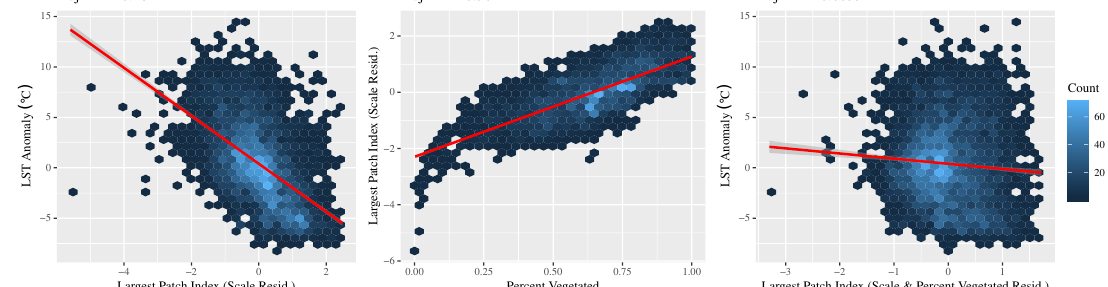
Figure 8. LST plotted against the largest patch index without controlling for the percent of vegetation ( left ) and after controlling for the percent of vegetation ( right ). The middle plot shows the relationship between the largest patch index and the percent of vegetation that accounts for most of the influence of the largest patch index on